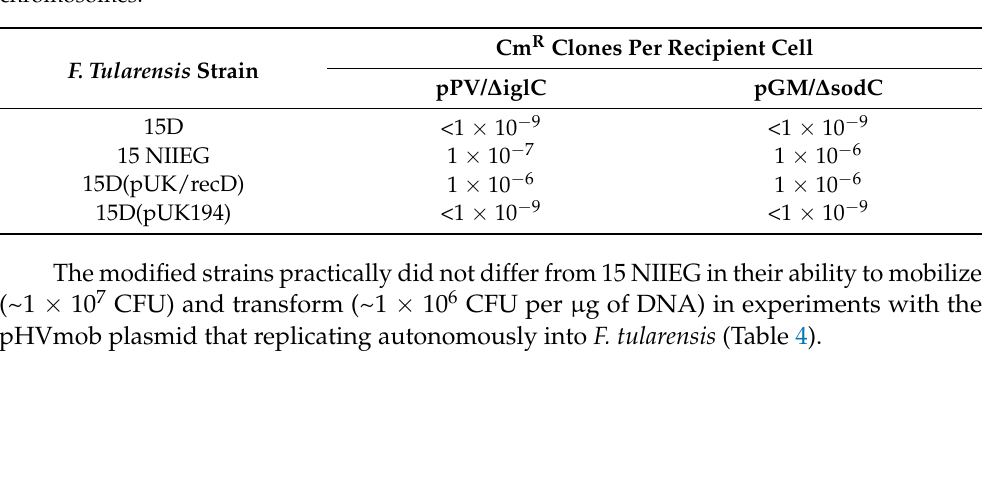
Table 3. Efficiency of the integration of pPV ∆ iglC and pGM ∆ sodC suicide plasmids into F. tularensis